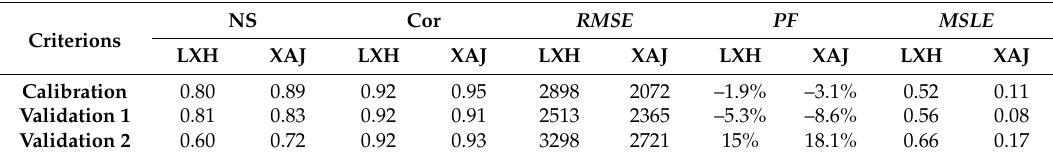
Table 1. Statistics of the LXH and XAJ model calibration and